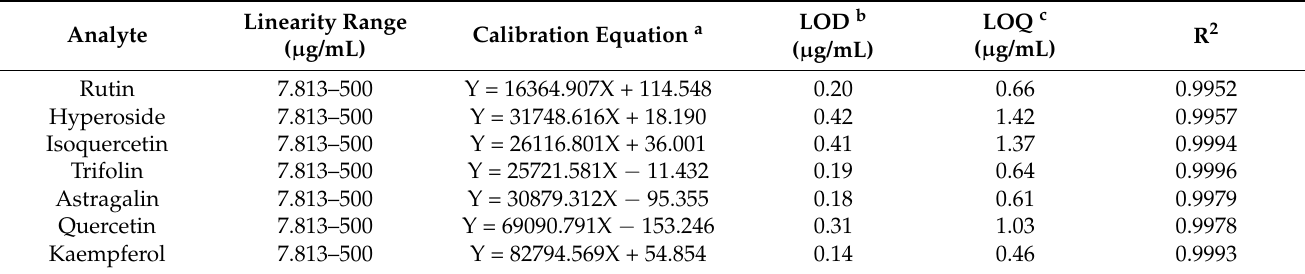
Table 3. Regression data and sensitivity for rutin, hyperoside, isoquercetin, trifolin, astragalin, quercetin, and kaempferol.